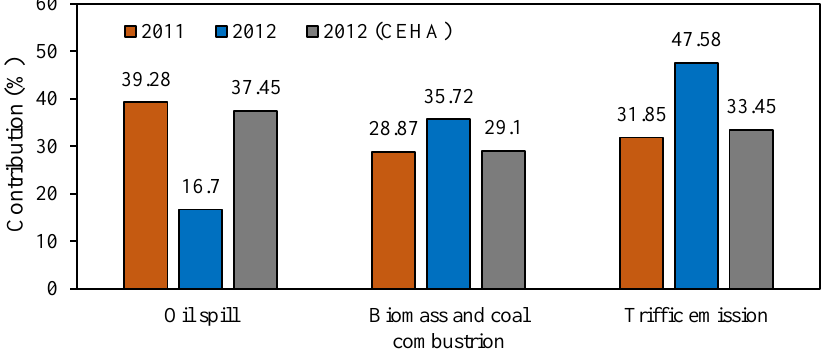
Figure 5. Source contributions based on the original PMF model.